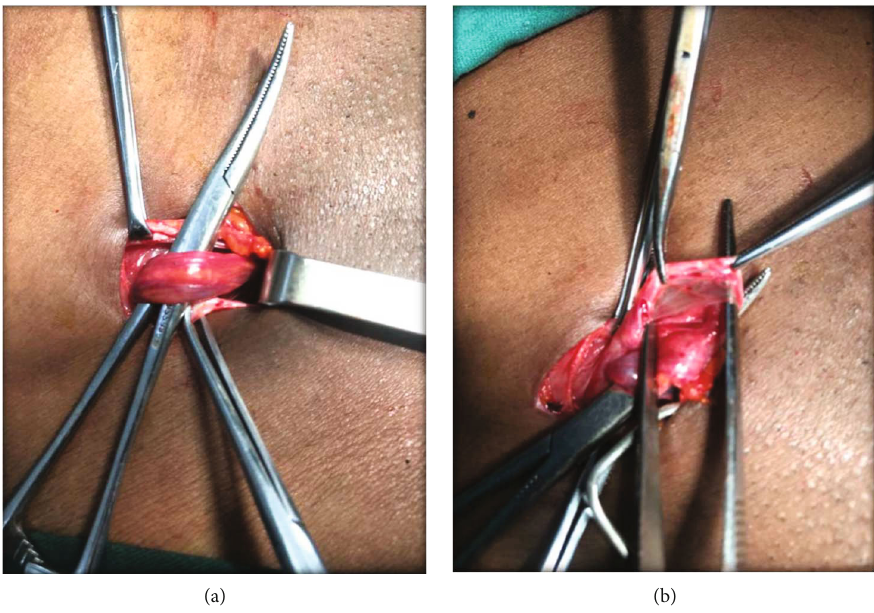
Figure 6: (a) Right inguinal dissection. (b) Closure of a right patent processus